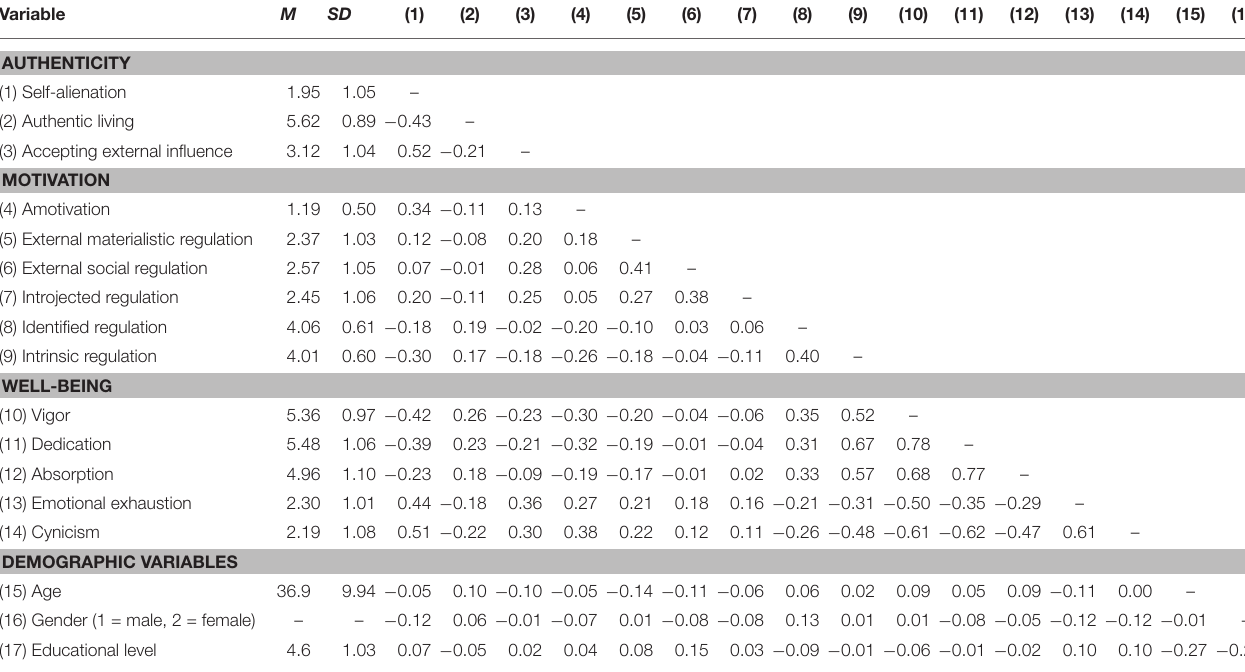
TABLE 1 | Means (M), standard deviations ( SD ), and correlations for the study variables. Variable